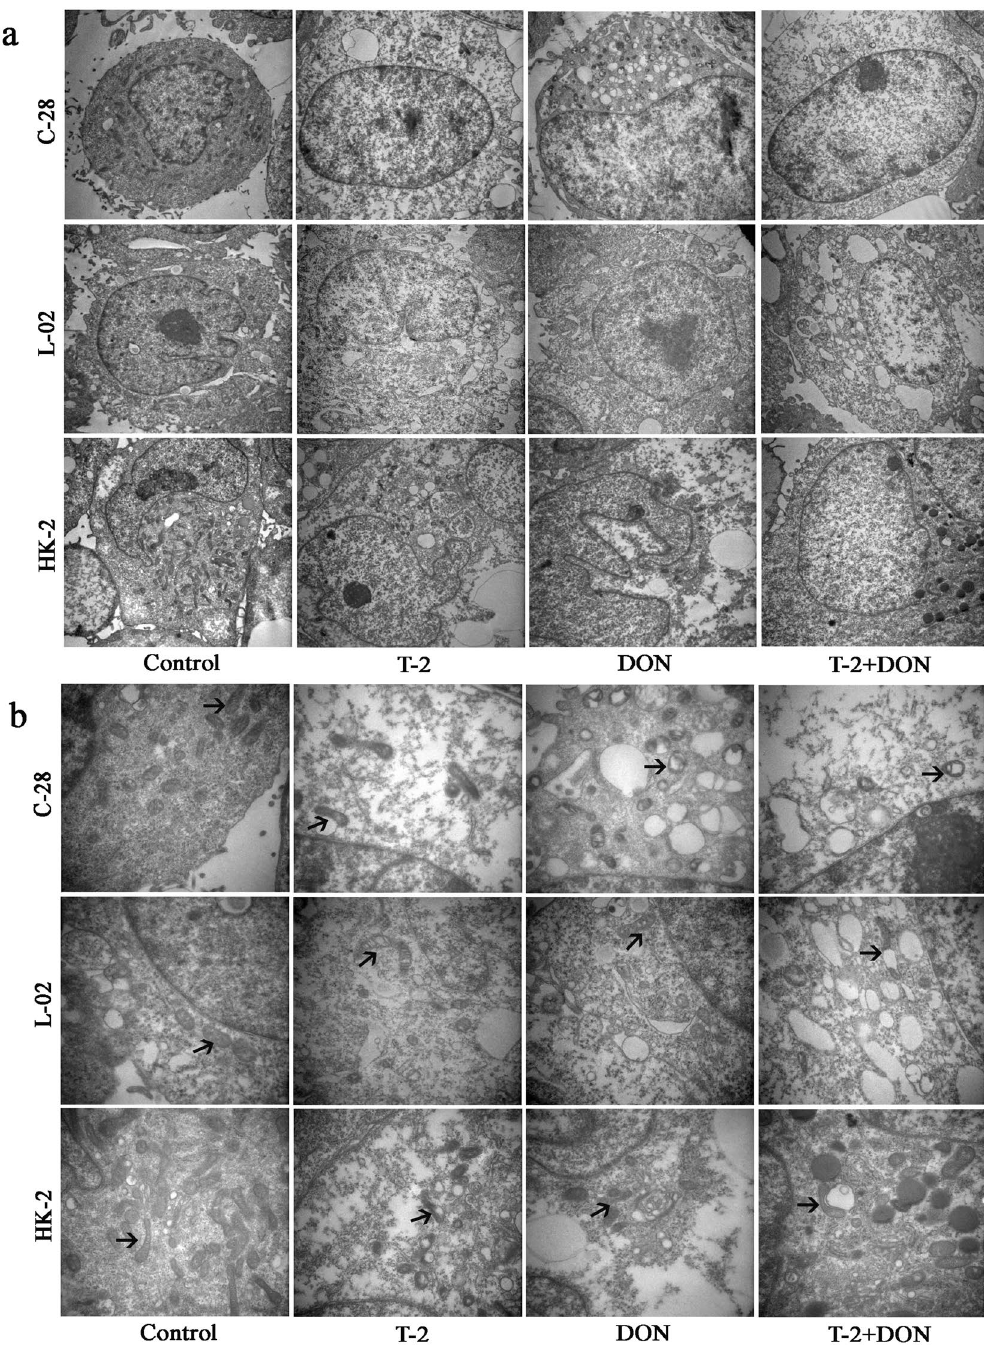
Figure 4. Ultrastructural changes induced by T-2 toxin and/or DON. C28/I2, L-02 and HK-2 cells were exposed to T-2 toxin (10 ng/ml) or DON (800 ng/ml), alone or in combination for 24 h and visualized by transmission electron microscopy (TEM) (a. TEM × 10,000; b. TEM × 30,000). Arrows indicate